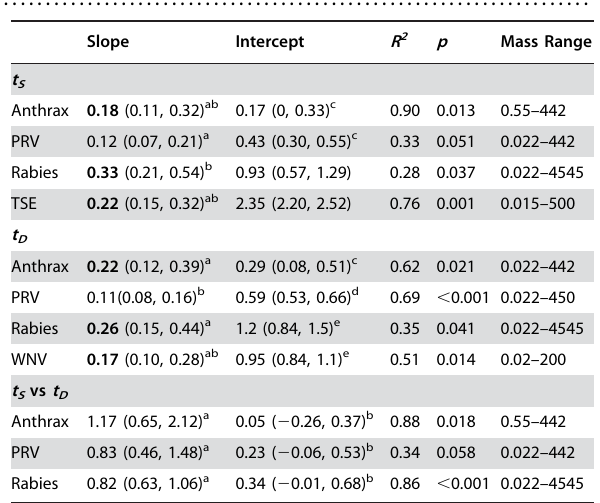
Table 1. Slope and intercept (2.5%, 97.5% values), R 2 , p values, and body mass range (kg) for t S (time from inoculation to 1st symptom), t D (time from inoculation to death), and t S vs. t D for